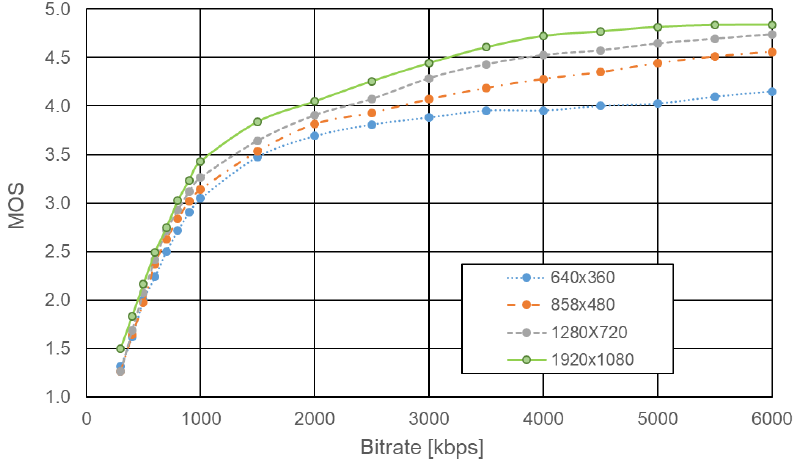
Figure 12. Results of the subjective quality assessment (MOS) for the VP9-encoded video as a function of bit rate for different spatial resolutions—measurements in laboratory.